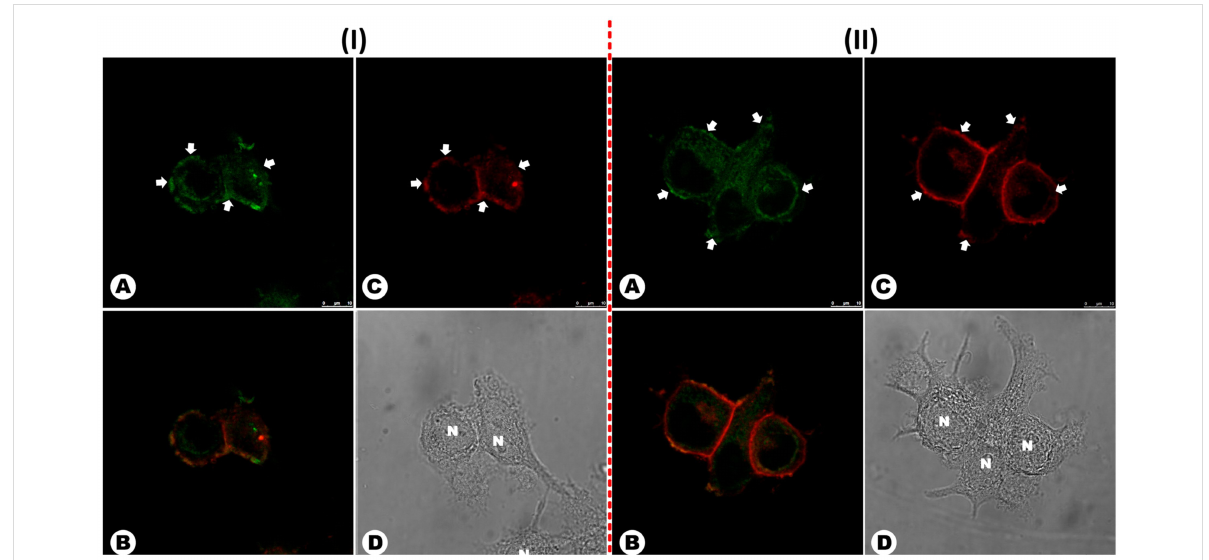
Figure 7: Co-staining experiments using the commercially available CellMask (red emission) and BTD-4APTEG (green emission) in (I) live and (II) fixed MCF-7 cells. (A) Plasma membranes stained with the designed BTD-4APTEG. (B) Overlay of (A) and (C) showing the orange emission as the result of both green and red emissions. (C) Plasma membranes stained with the commercially available CellMask. (D) Shows the normal morphol- ogy of the cells by phase contrast microscopy. Arrows indicate the peripherical accumulation of the dyes in the plasma membranes. The letter N indi- cates the nuclei of the cells (scale bar of 10 μ